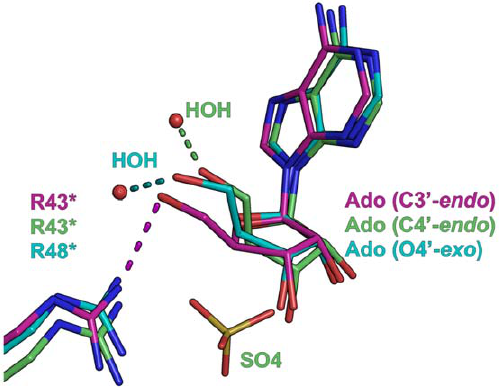
Figure 3. The different conformations of Ado ribosyl radical. Structural superposition of BsPNP233-Ado ( magenta carbon atoms), B. cereus adenosine phosphorylase (BcAdoP)-Ado-SO 4 ( green carbon atoms, PDB code 3UAW [52]) and Entamoeba histolytica PNP-Ado ( cyan carbon atoms, PDB code 3U40 [55]) complexes. The different puckers adopted by the ribose moiety of adenosine are labeled and the hydrogen bonds involving the 5 9 -OH group of Ado in each complex are represented by dashed lines . The sugar puckers were assigned by the pucker.py script of PyMOL [47].